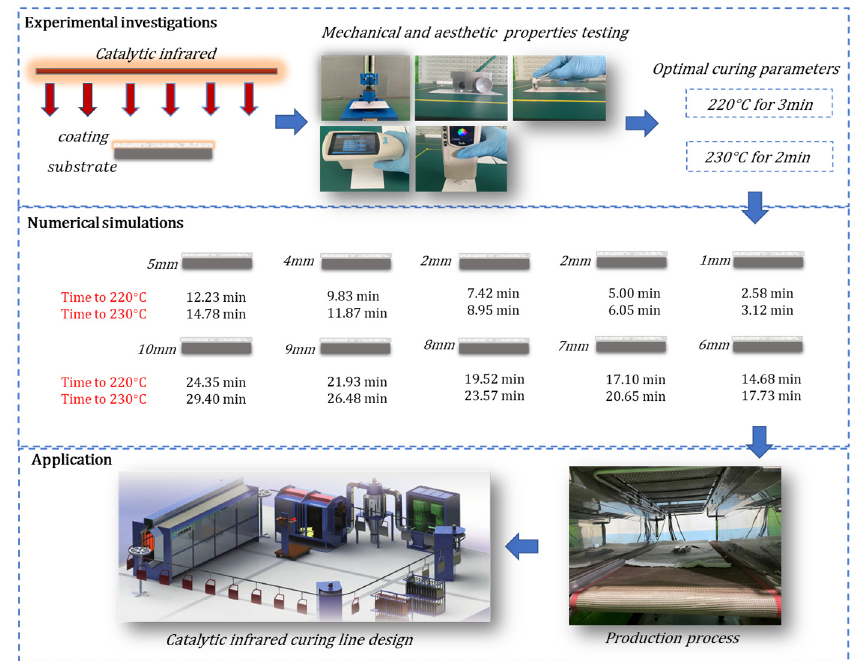
Figure 1. Research framework.